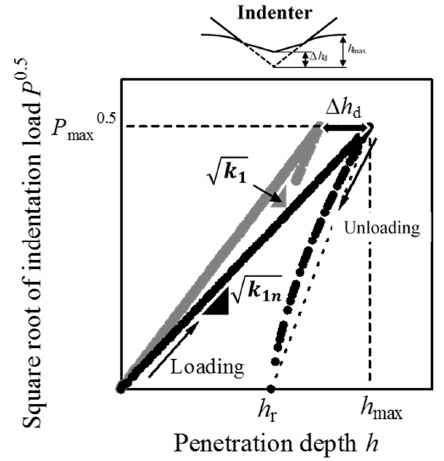
Figure 1. Schematic illustration of the effect of indenter elastic deformation on a P - h curve. In addition to k 1 , the relative residual penetration depth ξ , defined as h r / h max , where h r is the residual penetration depth, characterizes a P - h curve and nominally decreased by the elastic deformation of a cone indenter to be ξ n . A true ξ -value, which should be observed in a P - h curve using a rigid cone indenter with β d , can also be evaluated with the mechanical properties inputted into the FEM model [9,10]. The numerical analysis revealed that the evaluated ξ can be correlated with the nominal ξ n as a function of Δ h d / h max